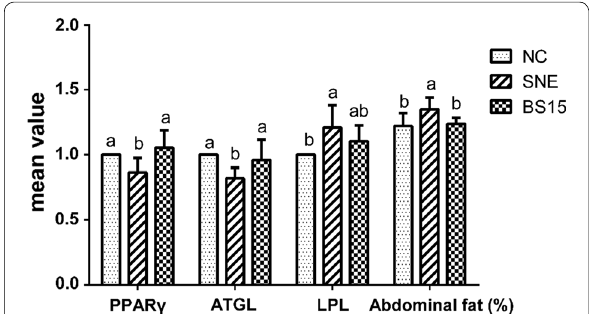
Fig. 2 Effects of Lactobacillus johnsonii BS15 on abdominal fat percentage and abdominal fat metabolism related mRNA expression in broiler. Means in the same row with no superscripts or with a com- mon superscript letter do not differ significantly (P < 0.05). Data are presented with the mean standard deviation (n 6; pen was used ± = as the experimental unit). PPAR γ peroxisome proliferator activated